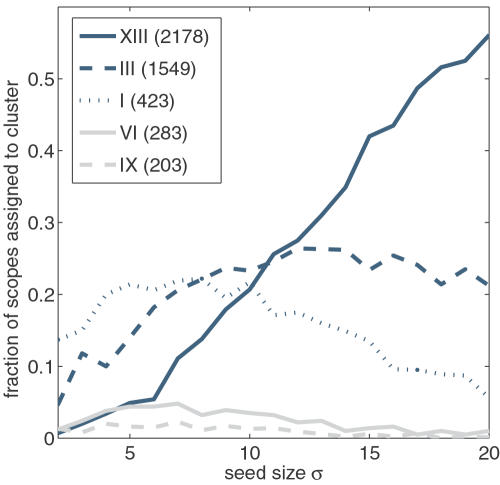
Assignment of combined biosynthetic potentials to selected clusters.The fraction of combined biosynthetic potentials, which are assigned to one of five selected clusters (XIII, APS; III, ATP; I, L-Glutamate; VI, dTTP; IX, Acetyl-CoA), is plotted versus the seed size.